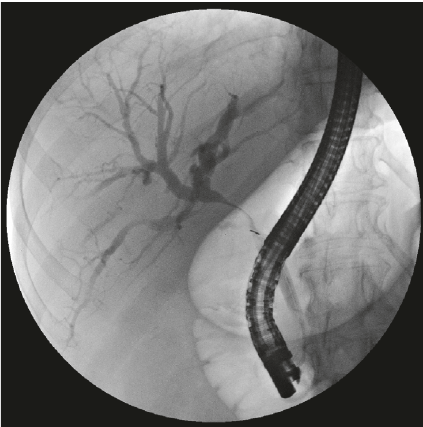
Figure 3: ERCP in a case of Mirizzi type II: filling defect of the CBD caused by a big stone.